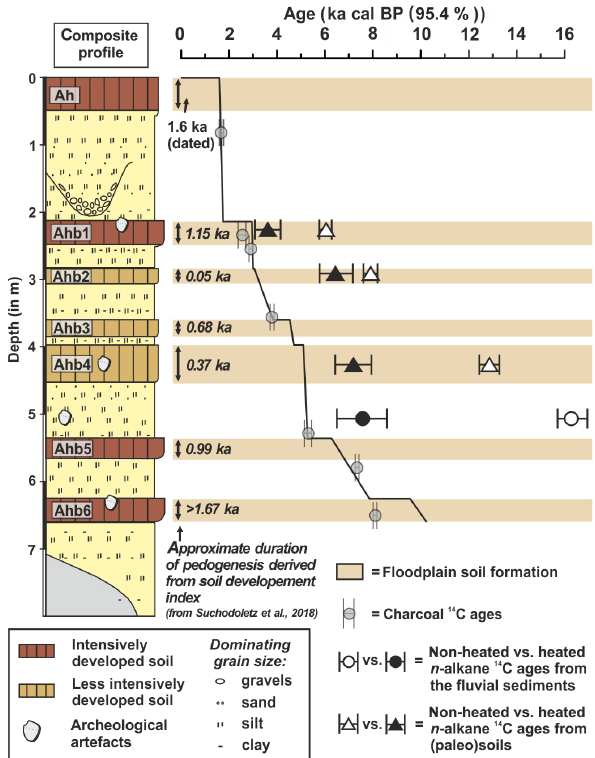
Figure 5. Comparison of nonheated n -alkane 14 C ages from the pretest and heated n -alkane 14 C ages that were re-extracted from the same samples of the investigated FSPS and heated with 120 ◦ C for 8h. For comparison, the independent age model based on 14 C-dated charcoal pieces and the soil development index (SDI) is also shown (von Suchodoletz et al., 2018). 14 C ages are given as calibrated age ranges in kacalBP (95.4%) with the calibrated median